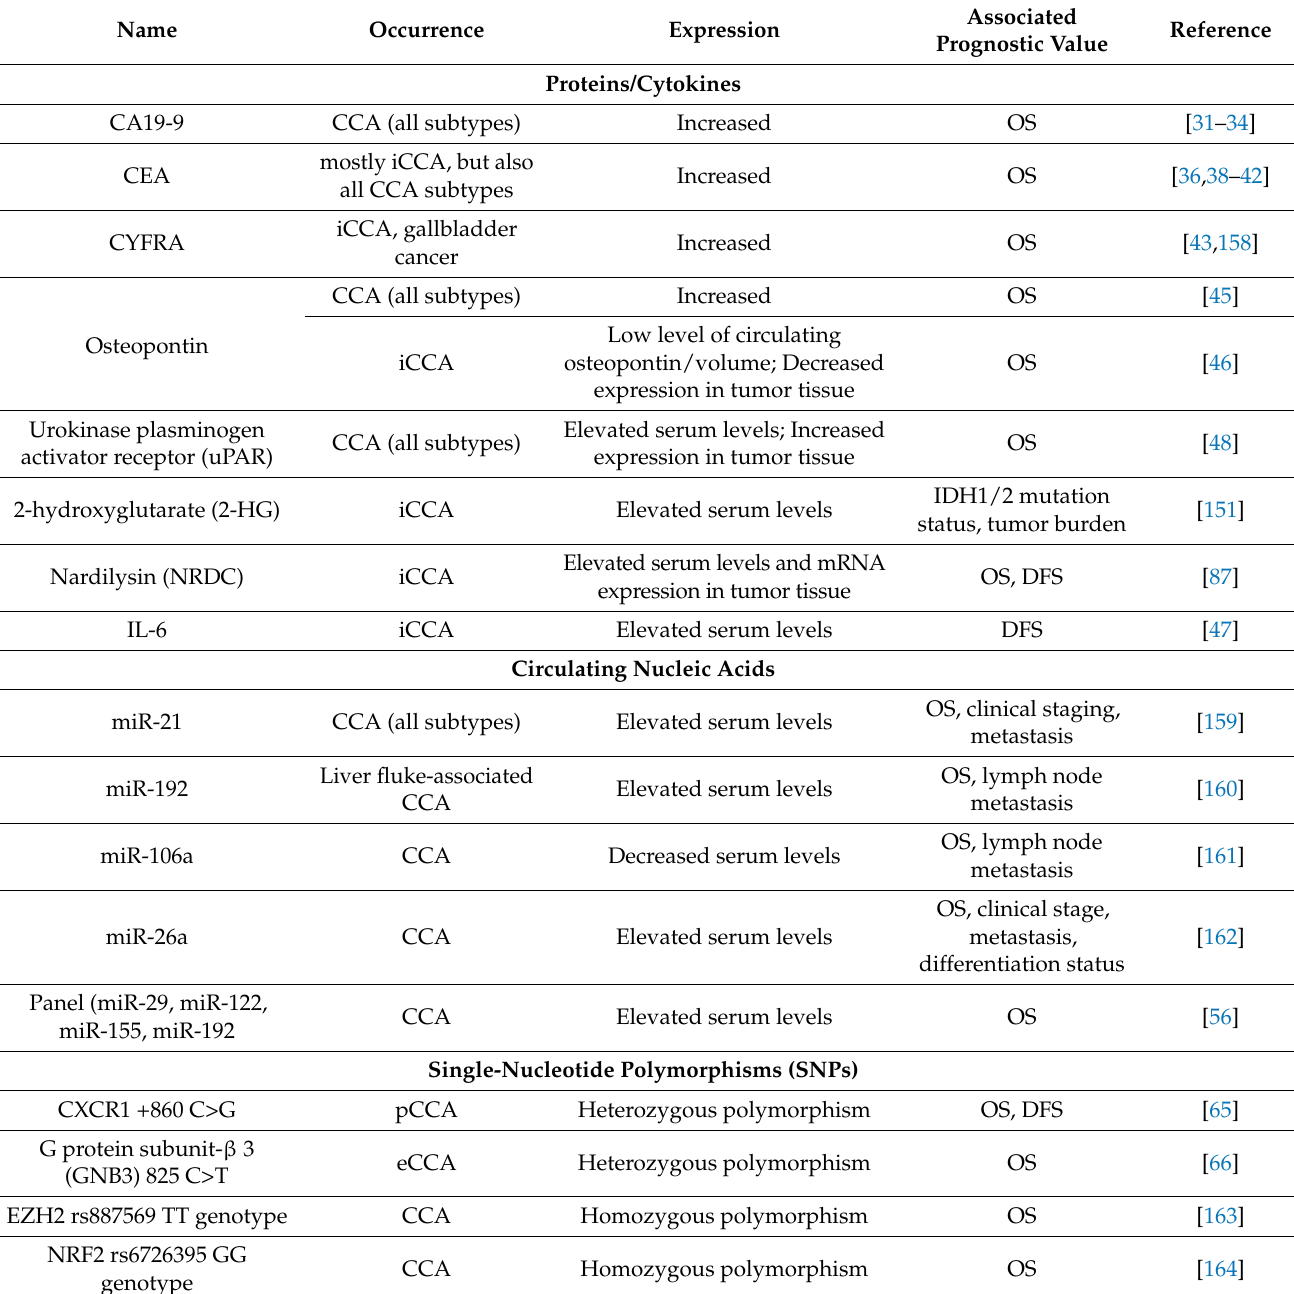
Table 1. Serum biomarkers associated with prognosis in